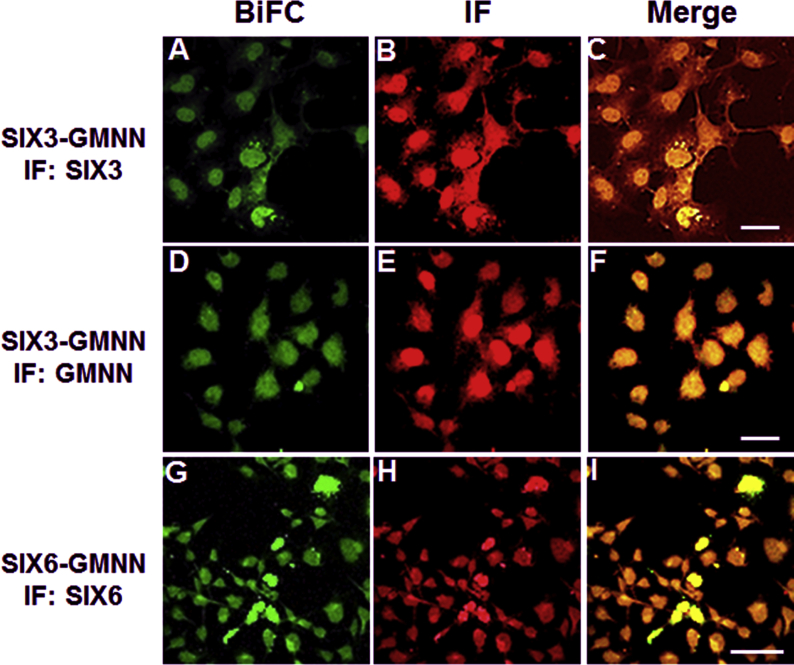
SIX3/SIX6 - GEMININ complex formation in living cells. The interactions of the pBiFC-VC155 SIX3 and SIX6 to pBiFC-VN155 (I152L) GEMININ were studied using BiFC in co-transfected COS-1 cells. Shown are representative confocal images. A) BiFC image of the SIX3-GEMININ complex, B) SIX3 immunostaining, D) BiFC image of the SIX3-GEMININ complex, E) GEMININ immunostaining, G) BiFC image of the SIX6-GEMININ complex, H) SIX6 immunostaining. C), F), I) Merged images. Scale bars, 15 μm